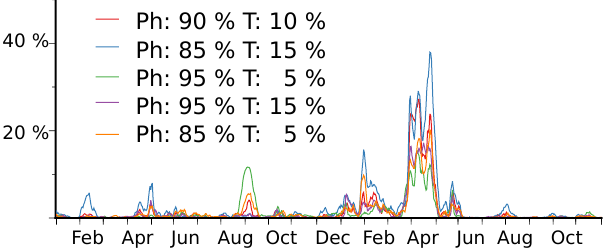
Figure 7. Fraction of stations with significant coincidence rates ( α = 0 . 05) among all phenological stations for 30-day windows and five different threshold combinations of extremely warm window- mean temperature and extremely early elder flowering. Note that the red line is the same as the bold red line displayed in Fig. 5, lower right